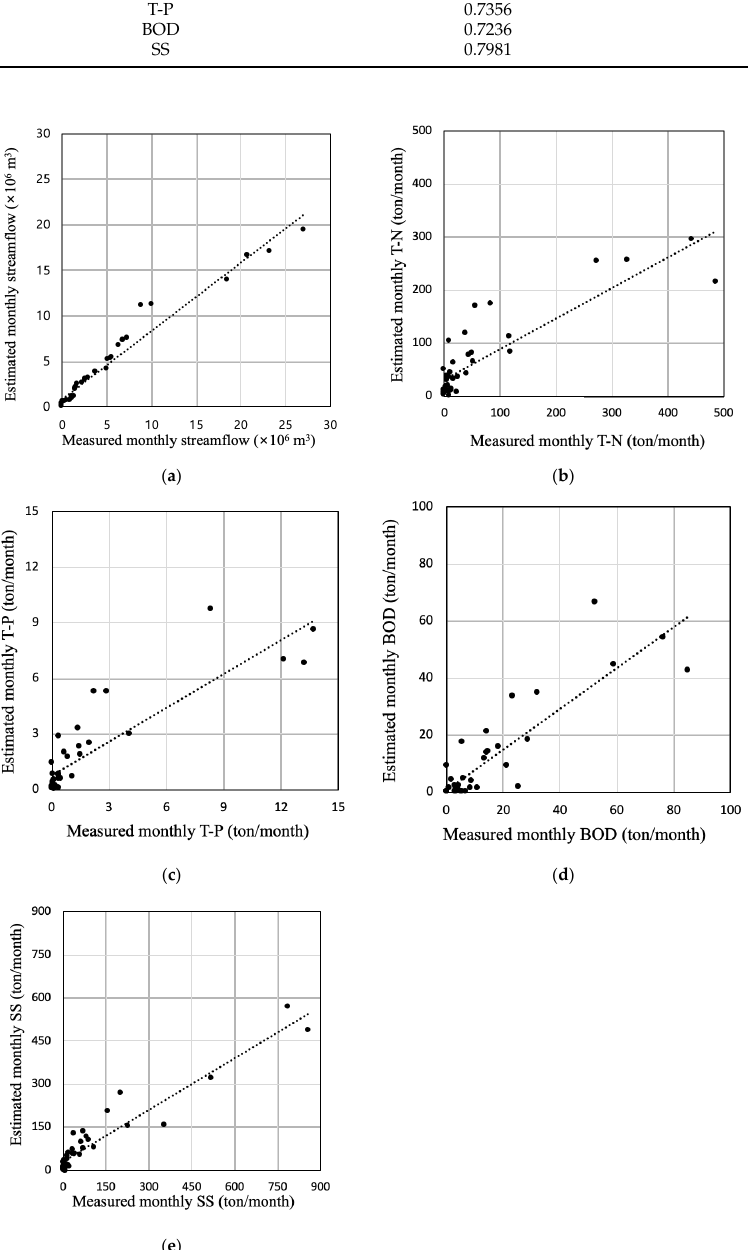
Figure 9. Scatter plots of measured and estimated monthly streamflow and nutrients in model validation: ( a ) streamflow; ( b ) T-N; ( c ) T-P; ( d ) BOD; ( e ) SS.